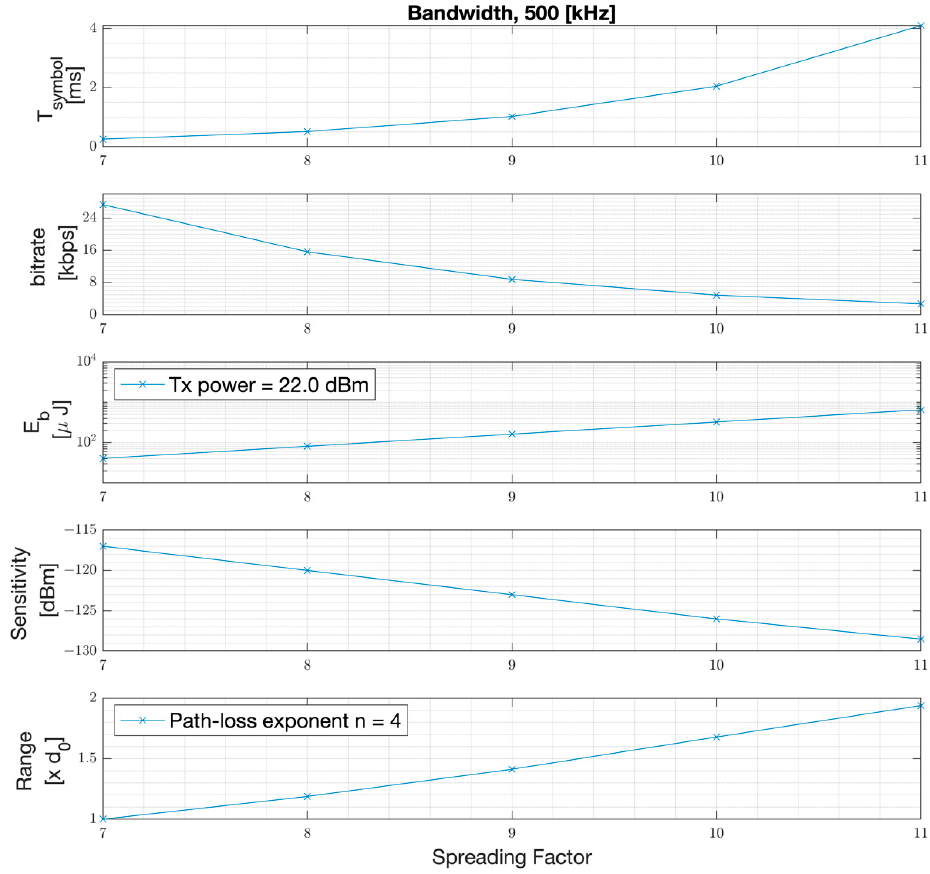
Figure 3. PHY symbol duration, PHY bitrate, energy per bit, sensitivity, and range versus SF.